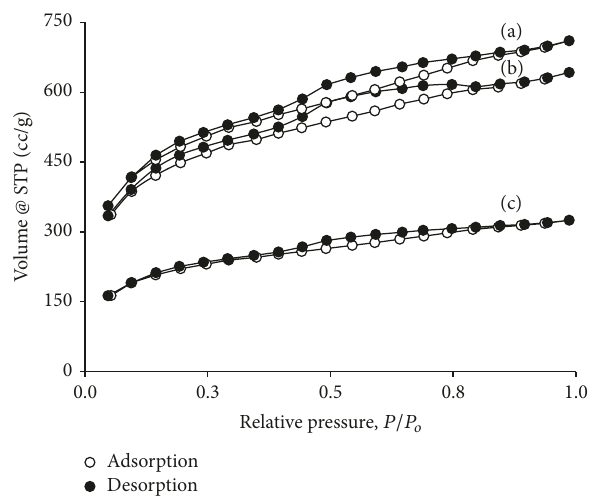
2 adsorption-desorption isotherms: PNS (a); PNS-SS- ADA (b); PNS-SS-ADA@CD-mPEG